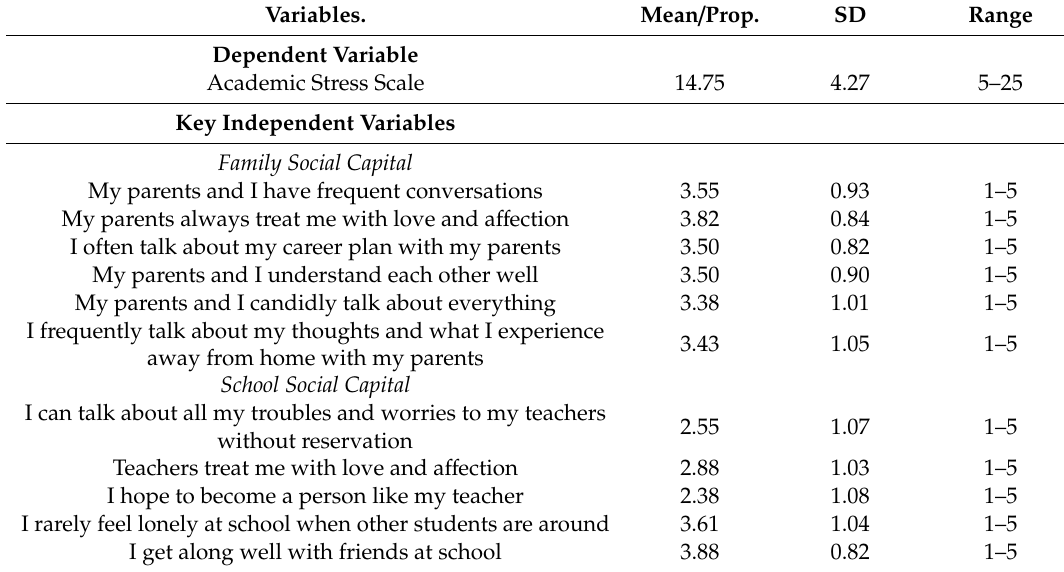
Table 1. Summary Statistics for Variables Included in Regression Models: KYPS, Wave 5, 2008 ( N =